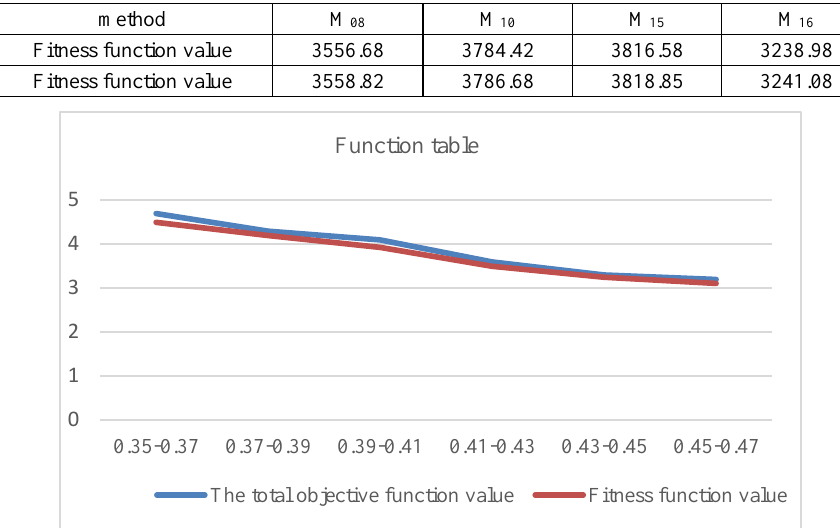
Table10. Calculated results of different ship types.